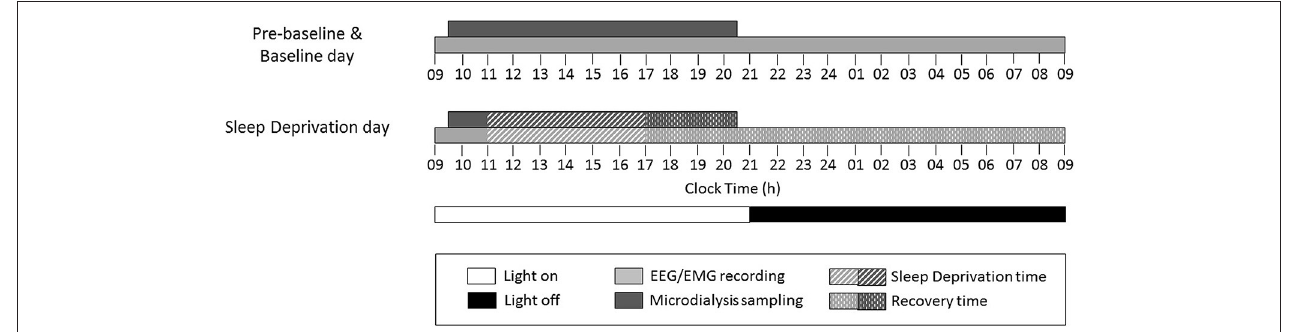
FIGURE 1 | Study design and timing of experimental procedures on each study